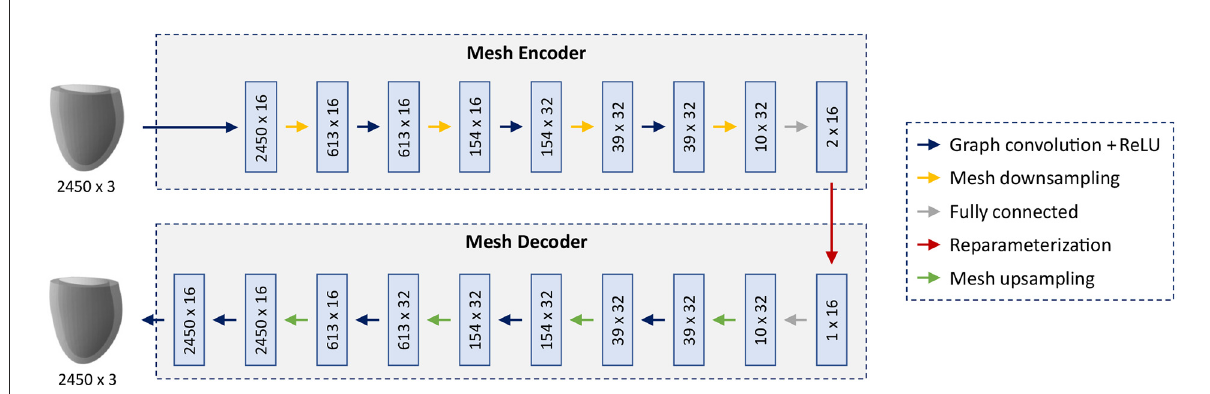
FIGURE2 Architecture of the mesh VAE. The input and output are cardiac anatomy models represented as 3D triangular meshes. All meshes in the dataset share the same connectivity and consist of 2,450 vertices with associated x,y,z coordinates. Multi-scale feature learning directly on mesh data is enabled by alternating graph convolution and sampling operations which are arranged in a hierarchical setup. The mesh encoder and decoder, connected by a 16-dimensional latent space, follow a symmetric design with the same number of levels and the same mesh resolution per